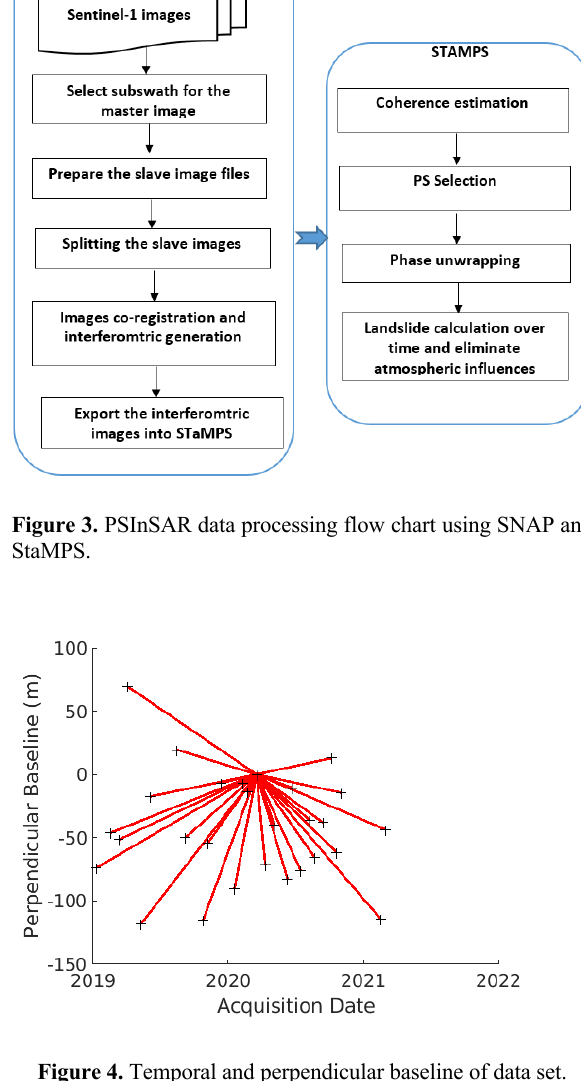
Figure 4. Temporal and perpendicular baseline of data